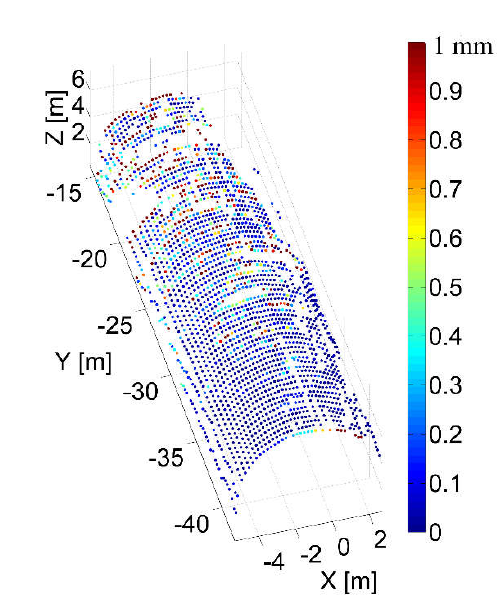
mm.In Table 3, means and std. devs. of representative points computed after applying RANSAC filtering algorithm are compared to the ones obtained without using RANSAC.